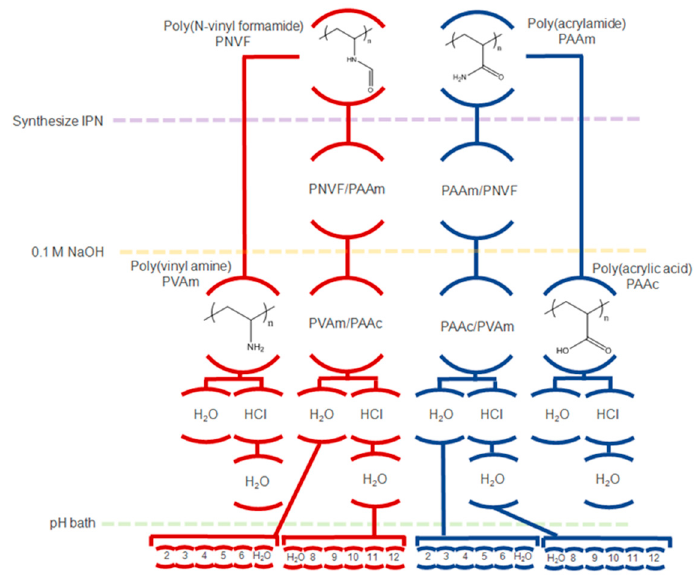
Figure 8. Schematic of formulations and the treatments. The conditions to achieve hydrolysis with the mildest conditions feasible to avoid degradation of the network (low NaOH, low temperature, and shortest time) were de- termined from literature to be 0.1M NaOH at 60 ◦ C for 24 h [30,47,48]. Cylindrical disks punched out by biopsy punch of PNVF, PAAm, PNVF/PAAm, and PAAm/PNVF hydro- gels were hydrolyzed by placing them in a container of 0.1 M NaOH and then placing them in the oven at 60 ◦ C for 24 h. The hydrolyzed gels were leached in water, changing the water multiple times to remove residual chemicals over 24 h. This leaves the carboxylic acid in the sodium salt form R-COO − Na + and the amines in the free base form R-NH 2 . Half of the hydrogels were placed in 0.1M HCl, changing the HCl solution multiple times for 24 h and then placed back in the water (changing the water multiple times) to remove residual HCl, again for 24 h. Thus, the carboxylic acid groups will be in the non-ionized state R-COOH, and the amines are in the hydrochloride salt R-NH 3+ Cl − . The half of the hydrolyzed IPNs of PVAm/PAAc and PAAc/PVAm which were not treated with HCl were placed in pH baths of either a pH of 2, 3, 4, 5, 6 and the IPNs that were treated with HCl were placed in a pH bath of either a pH of 8, 9, 10, 11 or 12. The gels were soaked for 48 h, changing the pH bath multiple times. The pH of the solution of all of the baths was measured. On many occasions, the pH was different from the original bath solution (even at equilibrium) because the gel acts as a buffer; therefore, a pH probe’s final pH was taken. The reported data were correlated with this measured